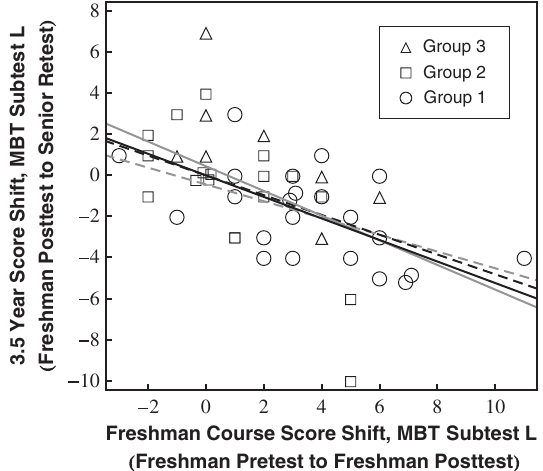
FIG. 6. Score shift from freshman posttest to senior retest on subtest L of the MBT versus shift during the freshman class. Solid fits are to the data for all groups (gray with floating intercept, black with x intercept fixed at zero). The fit with floating intercept has p ¼ 0 : 50 for an intercept equal to zero. The dashed line fits the group 1 data only with x intercept fixed at zero. The slopes of the fits with fixed intercepts are (cid:4) 0 : 52 (cid:5) 0 : 09 and (cid:4) 0 : 48 (cid:5) 0 : 09 , r ¼ 0 : 26 to r ¼ 0 : 59 . The intercepts retain their agreement